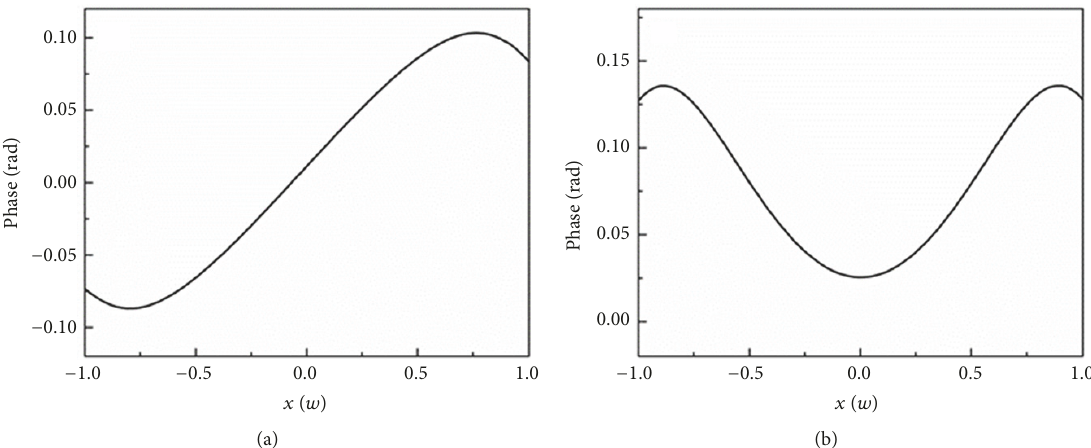
Figure 3: Phase curve of output signal when pump phase Φ ( x ) equals x 2 (a) and x 3 (b) ( L